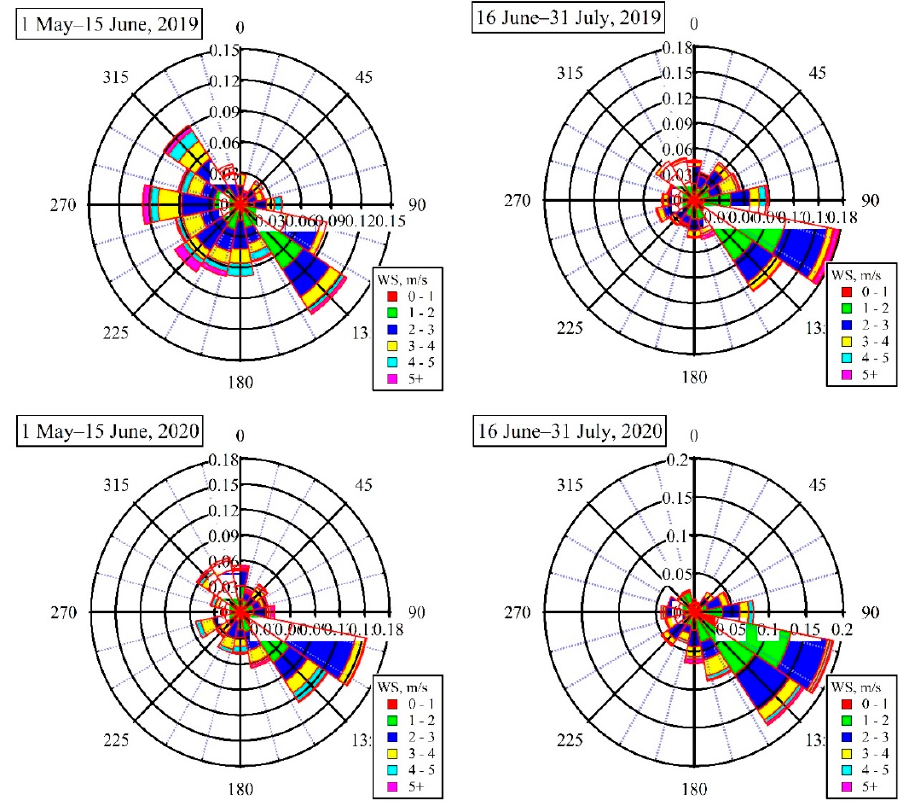
Figure 2. Comparison of wind rose plots during 1 May–15 June and 16 June–31 July of 2019 and 2020.